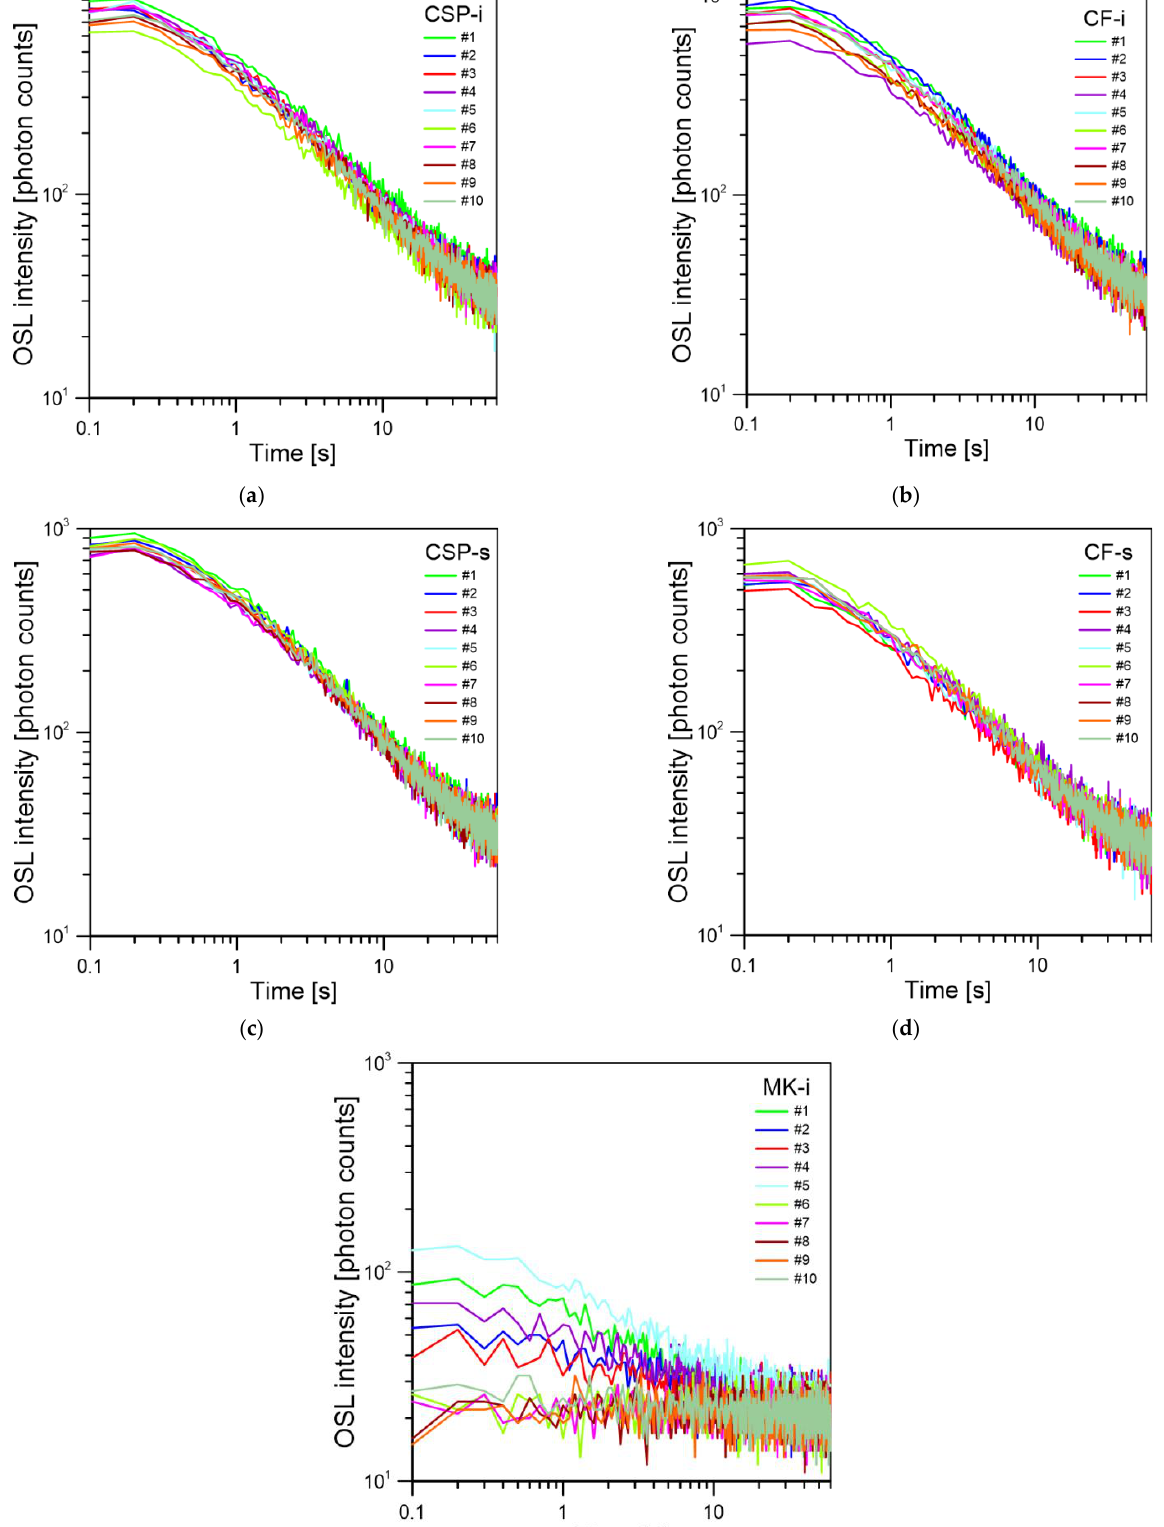
Figure 3. The CW-OSL decays for ten samples irradiated with a dose of 0.6 Gy and measured in the same conditions: ( a ) CSP-i, ( b ) CF-i, ( c ) CSP-s, ( d ) CF-s, ( e ) MK-i.